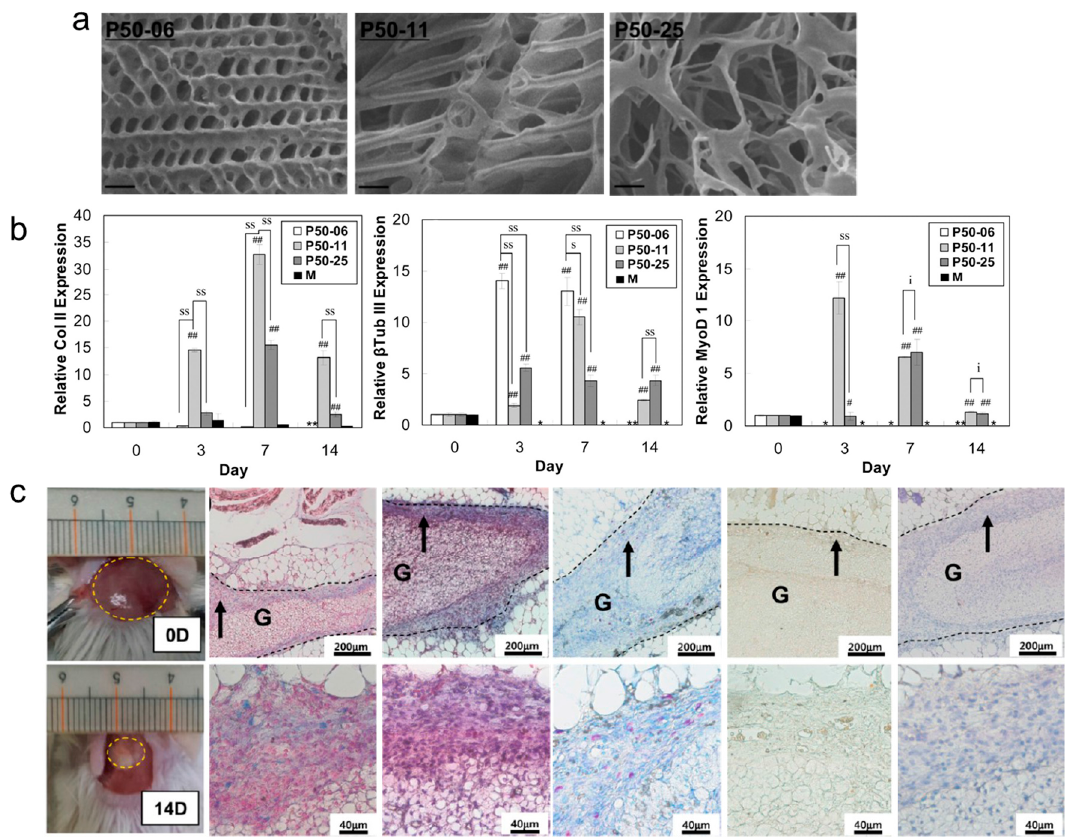
Figure 4. ( a ) SEM images of three kinds of PEG-L-PA thermogels prepared at 37 °C. The scale bar is 10 μ m; ( b ) In vitro studies, Col II, β Tub III, and MyoD1 gene expressions of ADSCs in PEG-L-PA thermogels, # and ## indicate p < 0.05 and p < 0.01 by Student t -test; s, ss, and i indicate p < 0.05, p < 0.01, and p > 0.05 by Student t -test; ( c ) In vivo mouse model of injected thermogel in situ with histological staining by alcian blue, Masson’s trichrome, toluidine blue, alizarin red S, and oil red O around the implant at 14 days. The regions marked by arrows are enlarged. The thermogel regions (G) are specified by the dotted curve. The scale bars are 200 and 40 μ m, respectively (reproduced with permission from [10]).